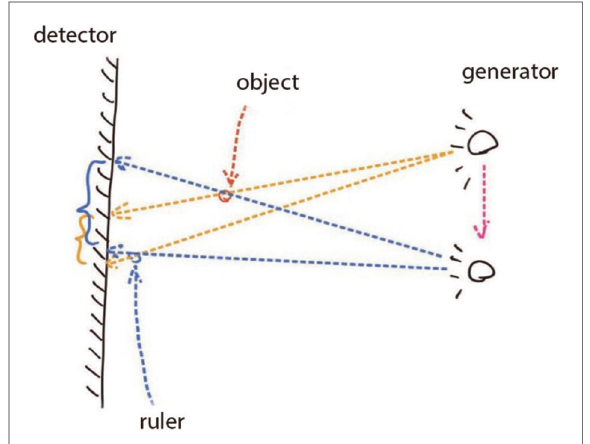
FIGURE 9 During the x-ray image capturing process, the source has to move from top to bottom to take multiple images; this means that the ruler markers ’ is captured from two different angles. Once the images are stitched according to features and not ruler markers ’ , a slight distortion can be seen in the markers. It does not represent a real distortion in the stitching of our method, but it veri fi es that our method solely depends on anatomical features to perform stitching and that its more